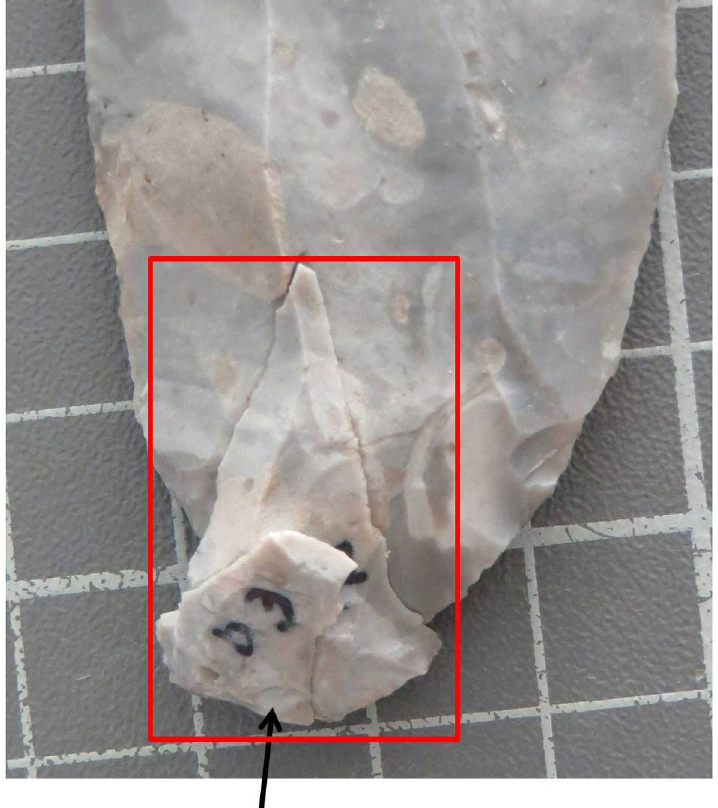
Figure 7. Blade-point 4.2, two conjoining pieces of shatter d3c and d1 with the black arrow showing direction of removal blow (photograph by the author). Gridlines on this image are 10mm